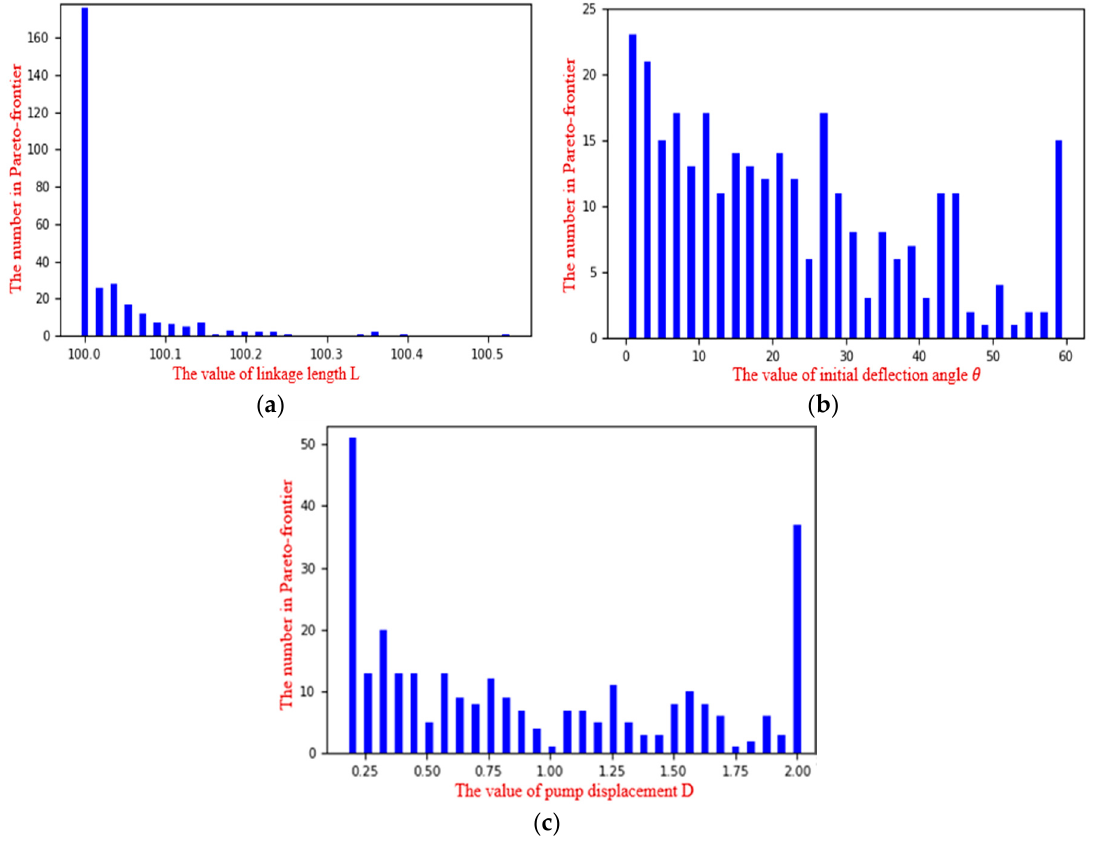
Figure 7. The Pareto front of optimization results of EHA. ( a ) The distribution of linkage length L in the Pareto frontier; ( b ) the distribution of initial deflection angle θ in the Pareto frontier; ( c ) the distribution of pump displacement D in the Pareto frontier.